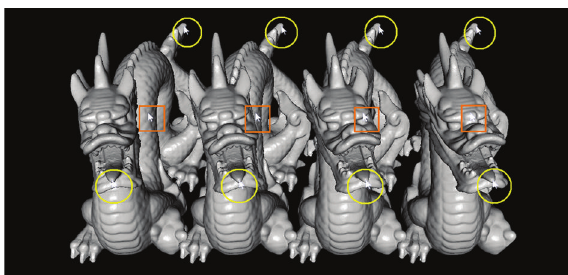
Figure 3: Dragon four-view stereo with three samples of stereo cursors on occluded (squares) and nonoccluded (circles) areas.